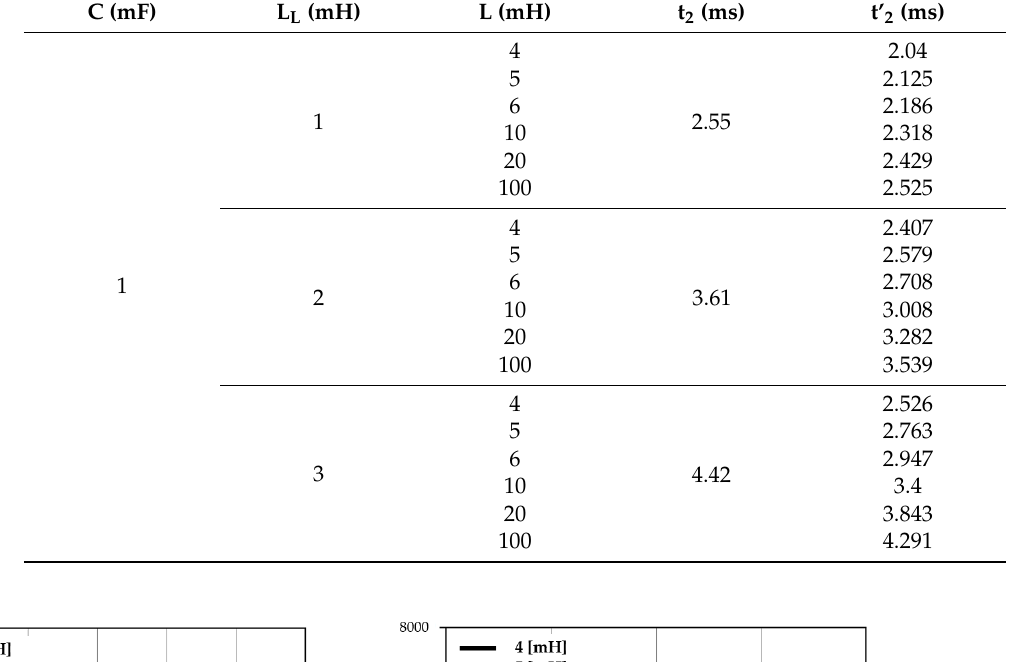
Table 1. ZCB parameters according to network capacitance C, inductance L, and system inductance L L .